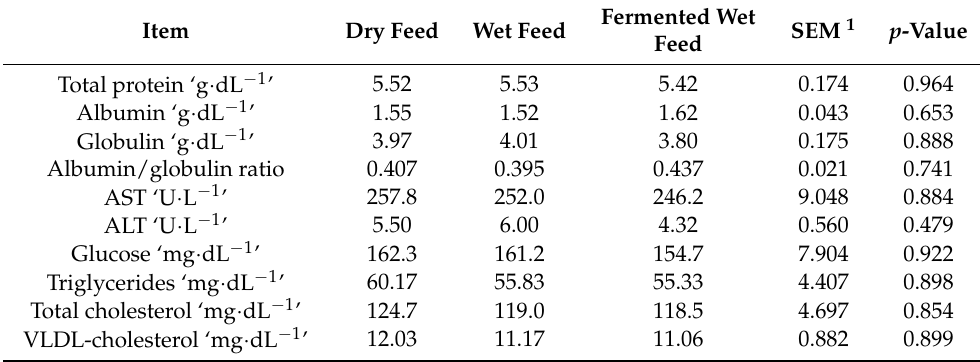
Table 5. Effect of dry, wet and fermented wet feeds on biochemical blood indices of broiler chickens at 35 days of